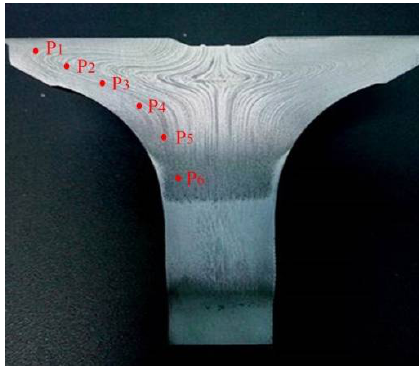
Figure 16. Microstructure observation point of forging valve profile.